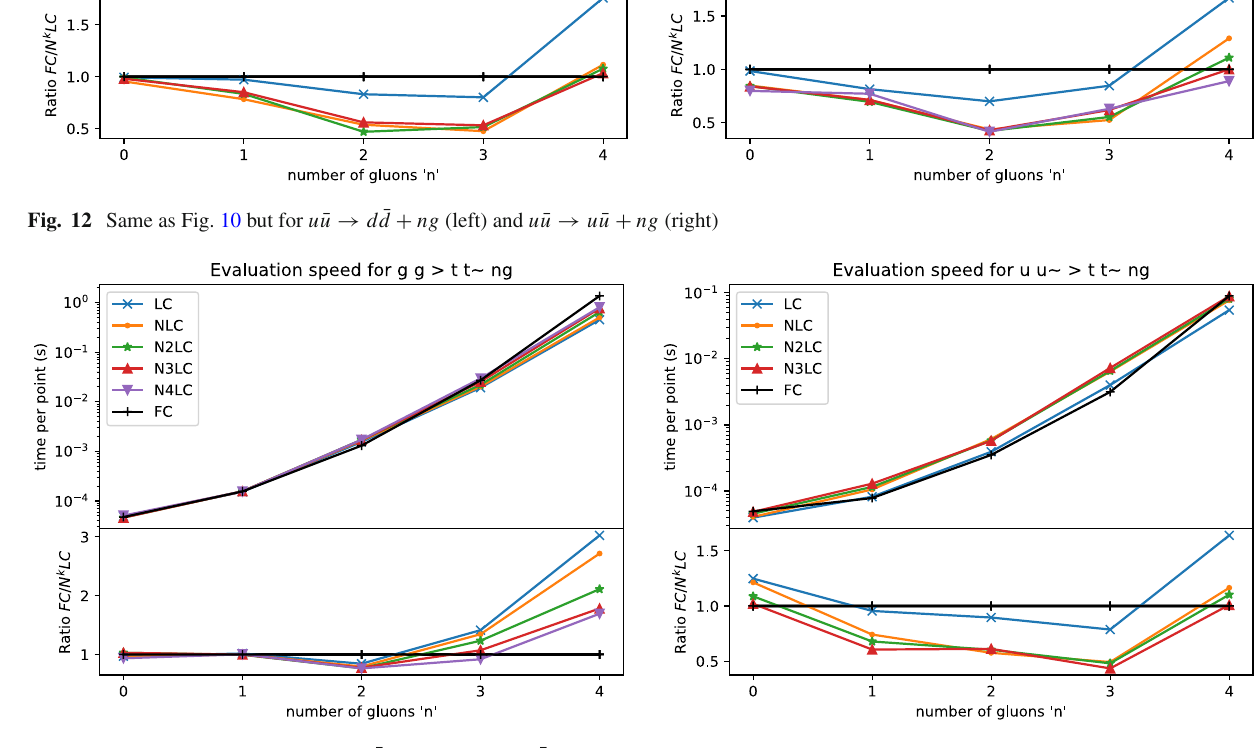
Fig. 13 Same as Fig. 10 but for gg → t ¯ t + ng and u ¯ u → t ¯ t +